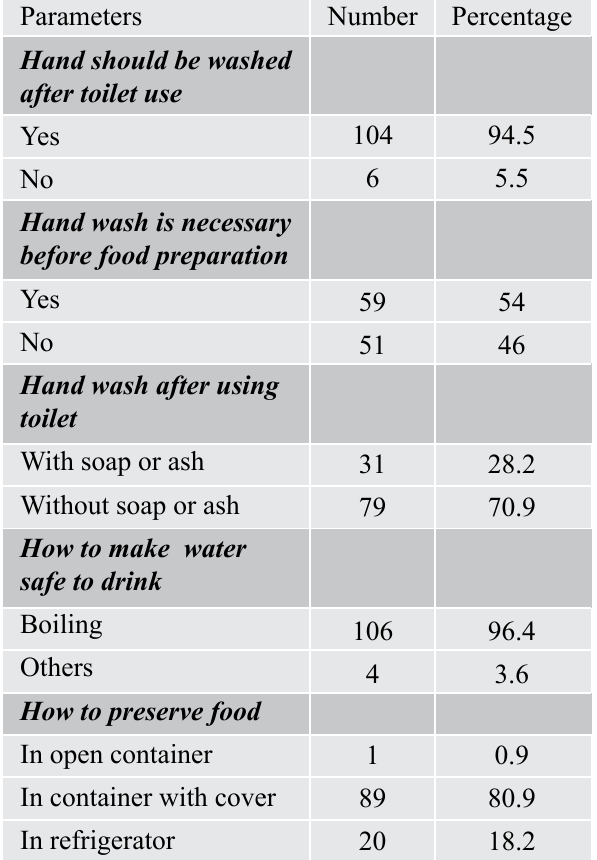
Table II: Chotpoti vendors’ knowledge of hand